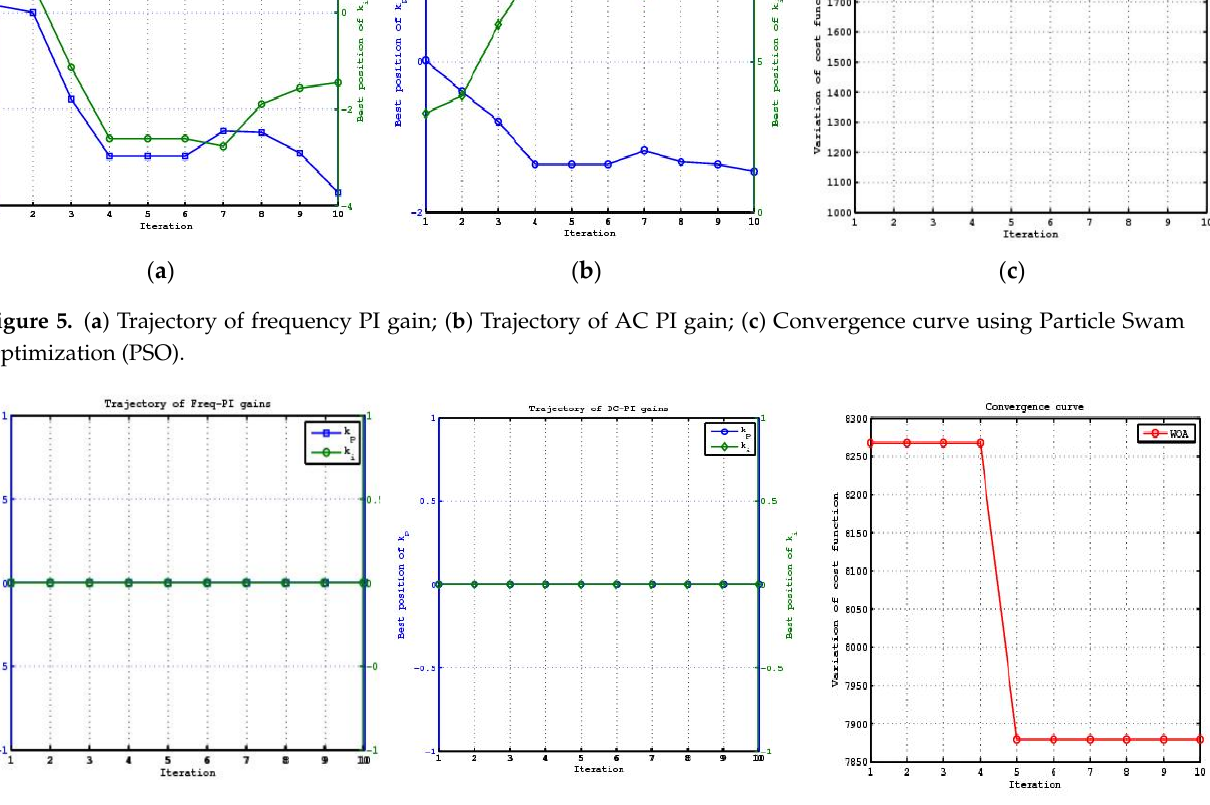
Figure 6. ( a ) Trajectory of frequency PI gain; ( b ) Trajectory of AC PI gain; ( c ) Convergence curve using Whale Optimization Algorithm (WOA).